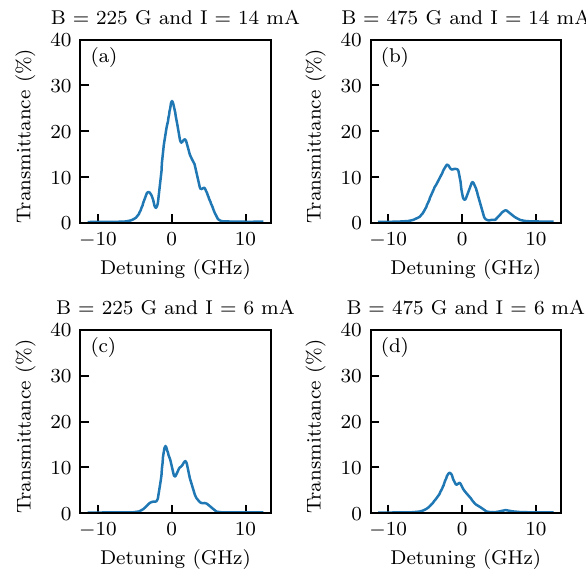
Figure 2. Some typical transmittance spectra of the HCL-FADOF. ( a ) The transmittance spectrum at the magnetic field of 225 G and the discharge current of 14 mA; ( b ) the transmittance spectrum at the magnetic field of 475 G and the discharge current of 14 mA; ( c ) the transmittance spectrum at the magnetic field of 225 G and the discharge current of 6 mA; ( d ) the transmittance spectrum at the magnetic field of 475 G and the discharge current of 6 mA.